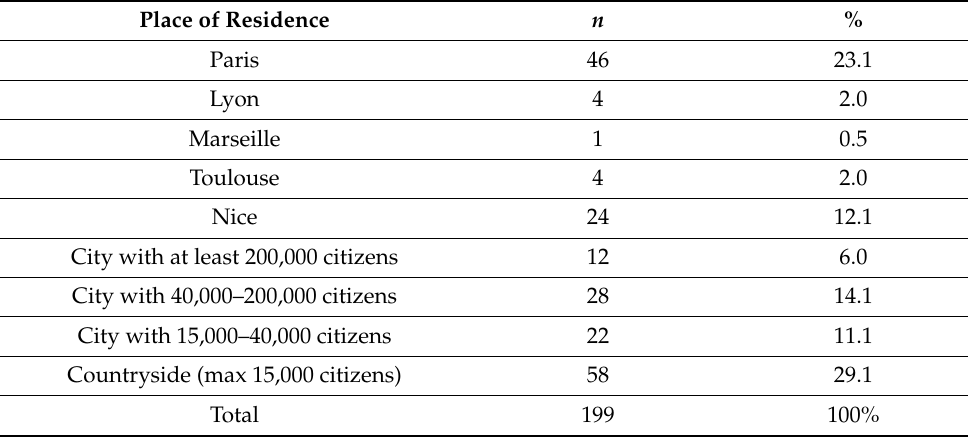
Table 1. Distribution of participants’ place of